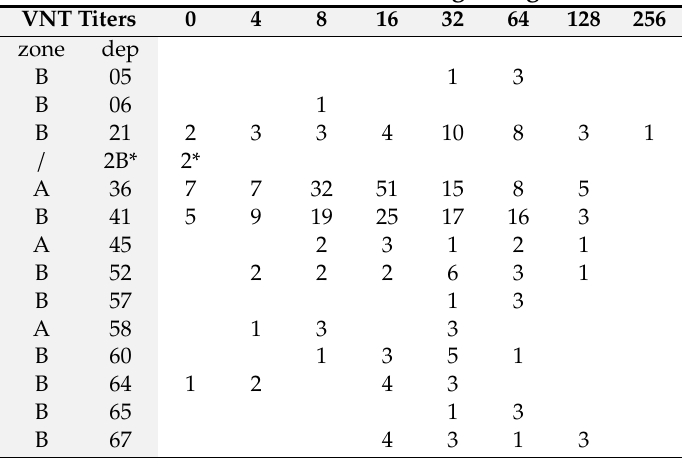
Table 3. VNT targeting BTV1 and BTV8 neutralizing antibodies observed among c-ELISA positive red deer according to the